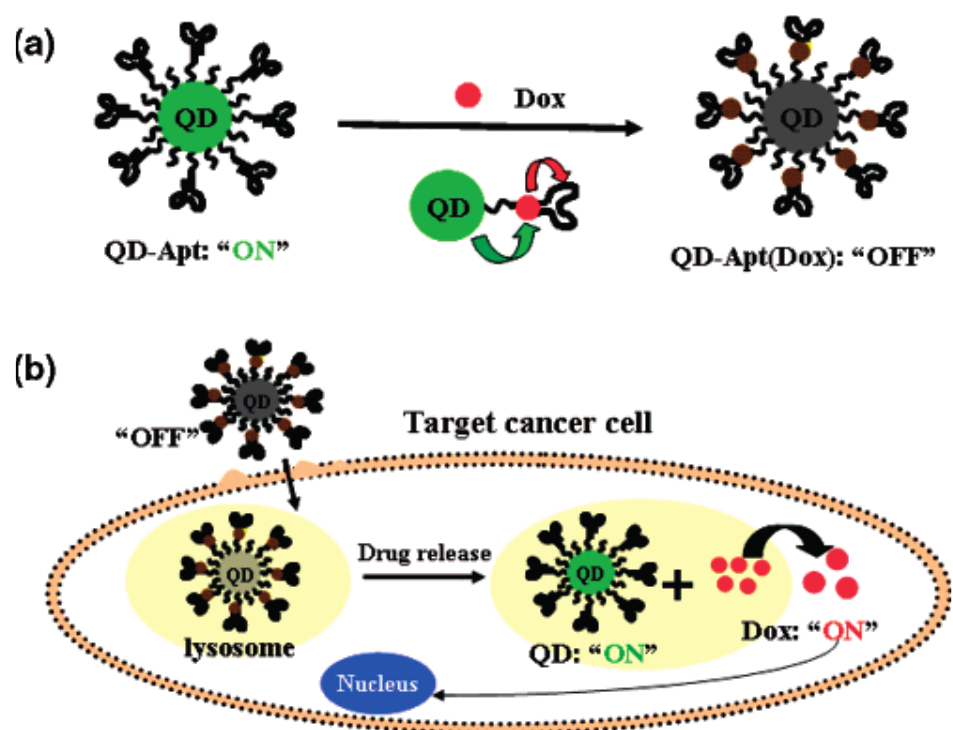
Scheme 5. ( a ) Schematic illustration of QD-Apt(Dox) Bi-FRET system; ( b ) Schematic illustration of specific uptake of QD-Apt(Dox) conjugates into target cancer cell through PSMA mediate endocytosis. Reproduced with permission from Reference